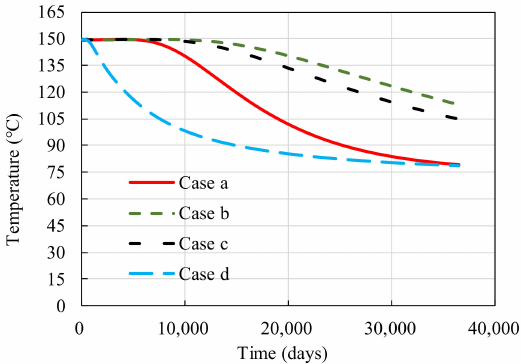
Figure 12. Thermal breakthrough curves for different fracture